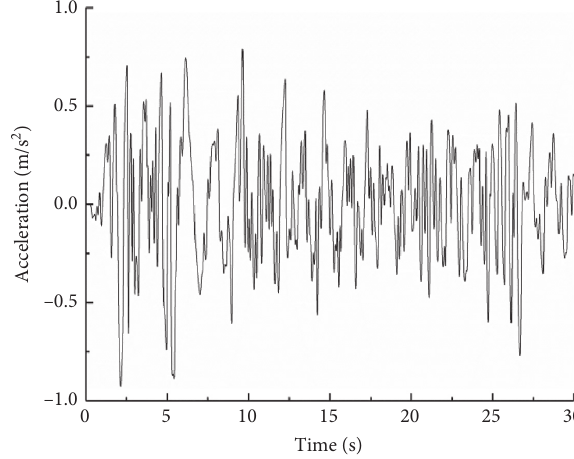
Figure 7: Comparison of simulation results. Table 4: Surface midpoint acceleration under different